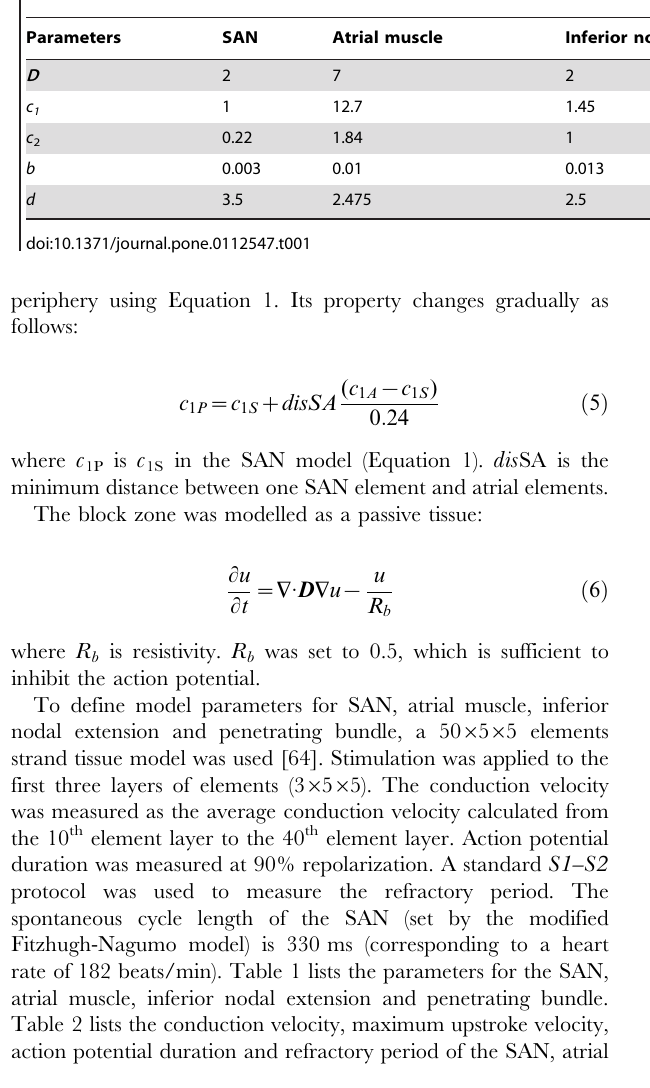
Table 2. Measurements of conduction velocity, maximum upstroke velocity of the action potential, action potential duration and refractory period of the SAN, atrial muscle and AVN from the Fitzhugh-Nagumo model and experiment.